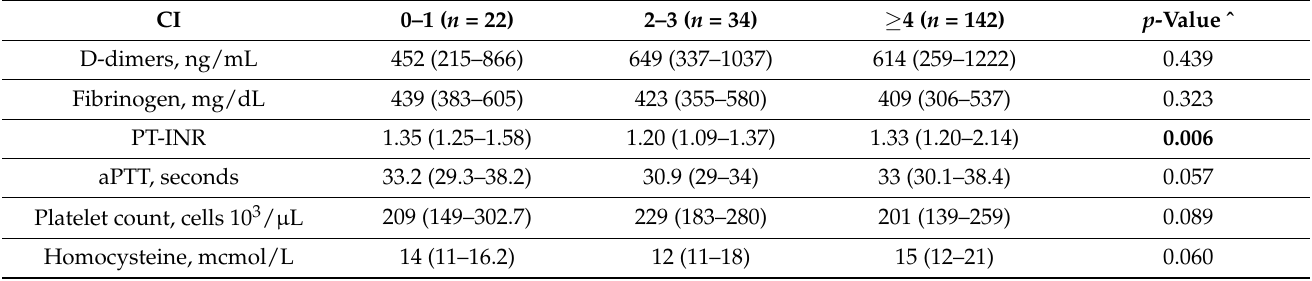
Table 4. Coagulation parameters according to the Charlson Comorbidity Index in IE patients.